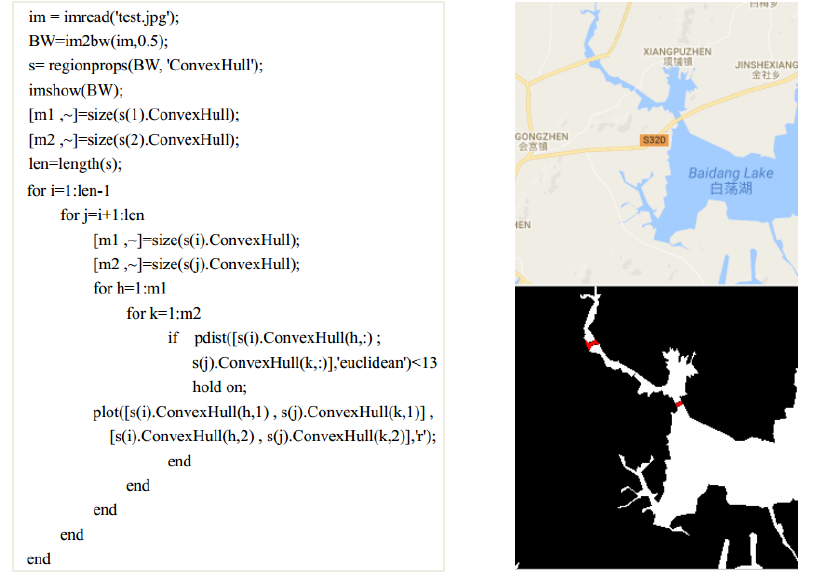
Figure 10. Water-area fracture connection.